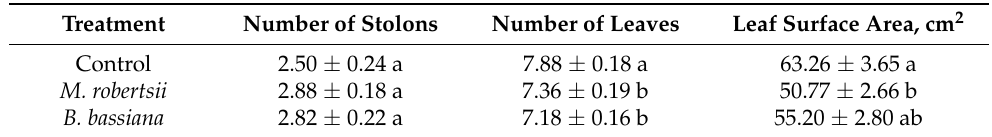
Table 2. Effect of treatment with EIPF on the biometrics and leaf area of Solanum tuberosum (50 plants were used for each treatment). Values are means ±